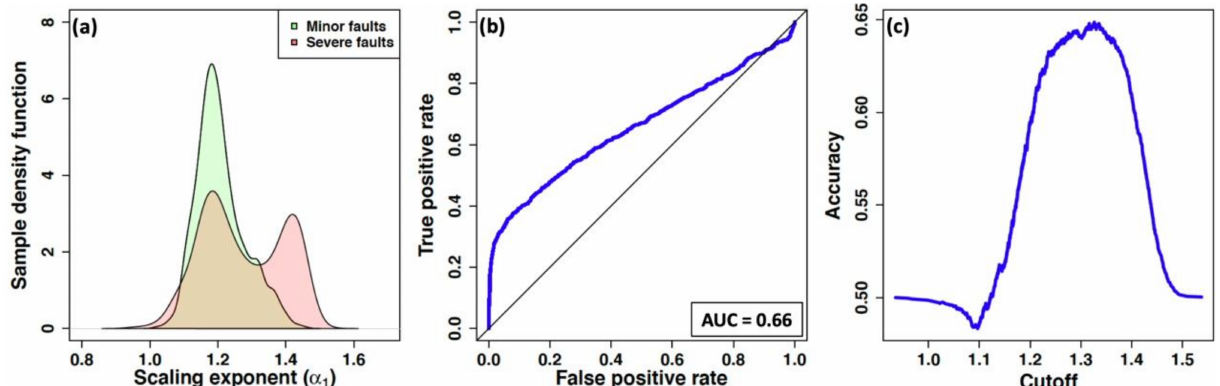
Figure 11. ( a ) Scaling exponent ( α 1 ) distributions of bearing vibration signals (1000 samples each) collected from faulted bearings. ( b ) ROC curve for the proposed method. ( c ) Accuracy vs. cutoff